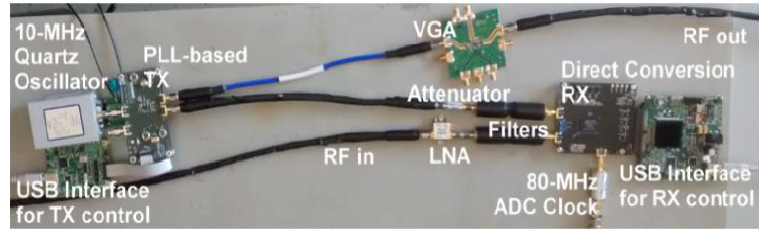
Figure 11. Photograph of the circuit used in the system developed by Pagliari et al. [69]. Reprinted with permission from [69]. LNA, low noise amplifier.